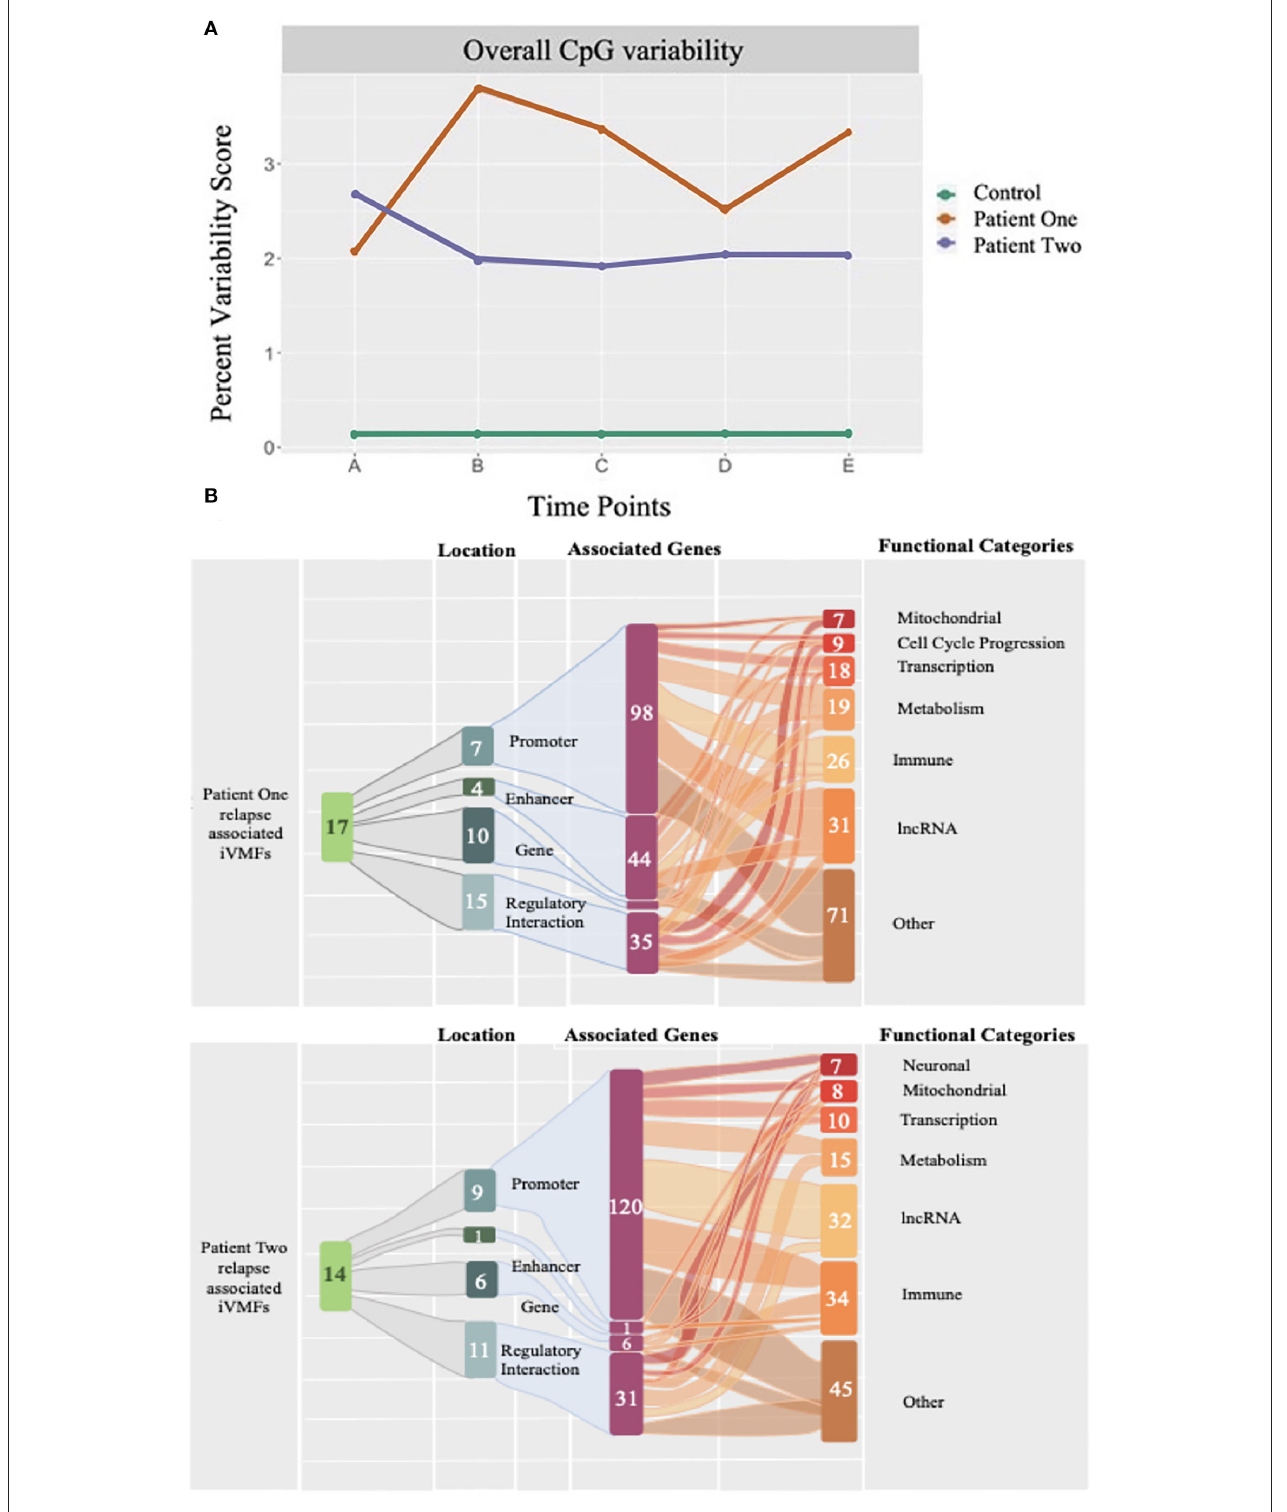
FIGURE 3 | The percent dynamic variability of unique CpG methylations of the epigenetic code in ME/CFS patients and an age gender matched healthy control over a year. DNA methylomes were analyzed at 5 time points for 2 ME/CFS patients and an age/gender matched healthy control. Each point (A-E) represents the statistically significant unique differentially methylated CpG sites at that time point in a longitudinal study lasting 1 year, expressed as a percentage of the total